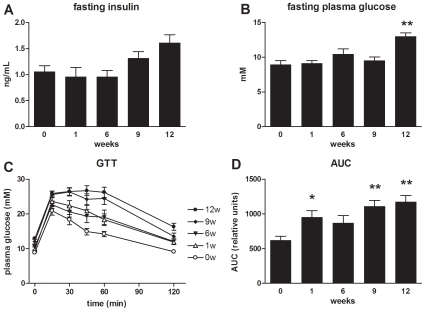
Effect of HFD feeding on fasting plasma insulin and glucose levels and glucose tolerance.Plasma insulin (A) and glucose (B) levels determined after a 5 hr fasting period. A glucose tolerance test (GTT) (C) was performed 2.5 weeks prior to inclusion into the study (not shown) and each animal underwent a second GTT, in week 0, 1, 6, 9, and 12 of HFD feeding (n = 15 each). After a 5 h fast, animals received 2 g glucose/kg body weight (i.p.). Glucose was recorded at the time points indicated and the area under the curve (AUC) (D) was calculated. Values are means ± SEM. **P<0.01; *P<0.05